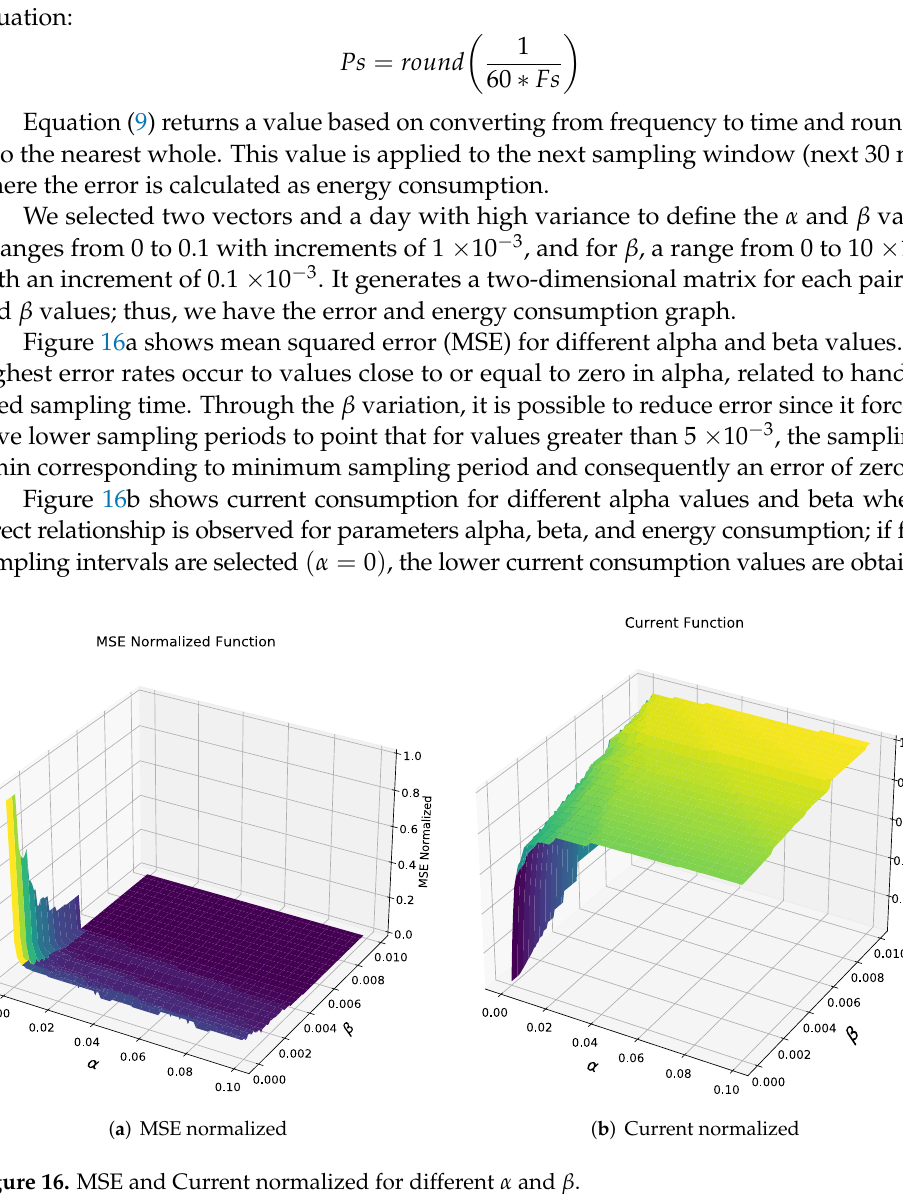
Figure 16. MSE and Current normalized for different α and β